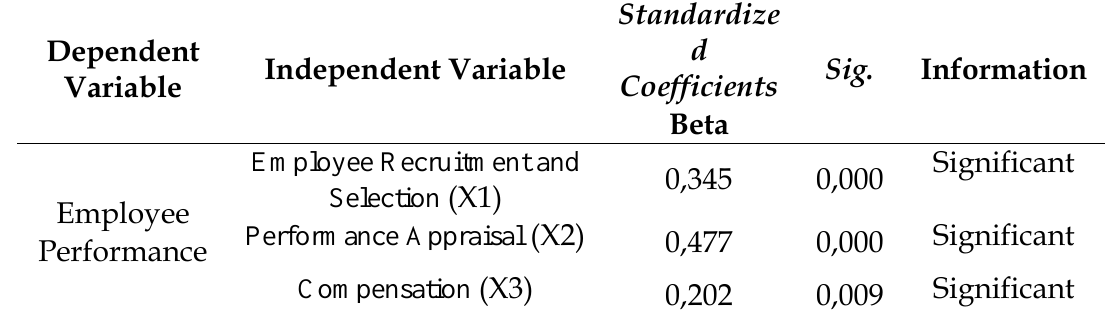
Multiple Linear Regression Test